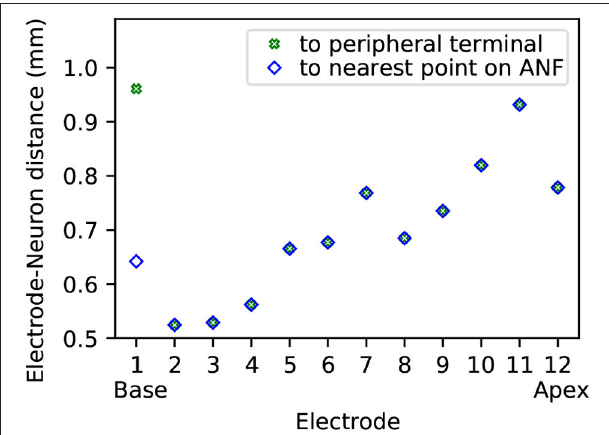
FIGURE 3 | Electrode-neuron distance for each of the twelve electrodes in the model. The distance is displayed both as distance to the closest point along the beginning of the reconstructed neuron paths ( ≡ modeled peripheral terminals), and as distance to the closest point along the entire length of all reconstructed neuron paths ( ≡ modeled